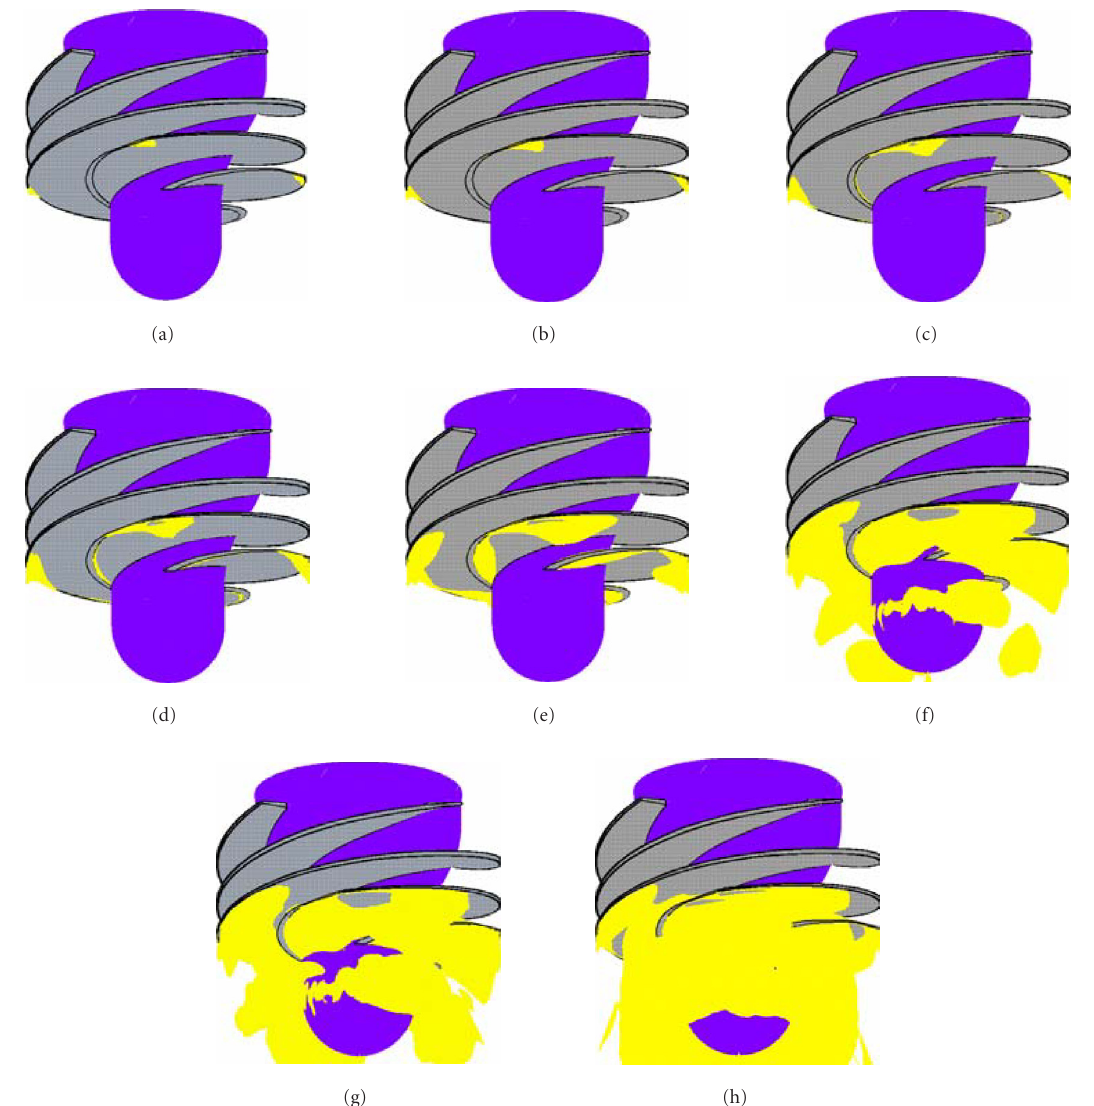
Figure 8: Development of the two-phase areas as the cavitation number decreases (corresponding to red squares reported on Figure 7).